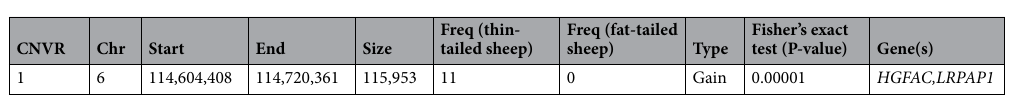
Table 4. association test between cases (fat tail sheep breeds) and controls (thin tail sheep